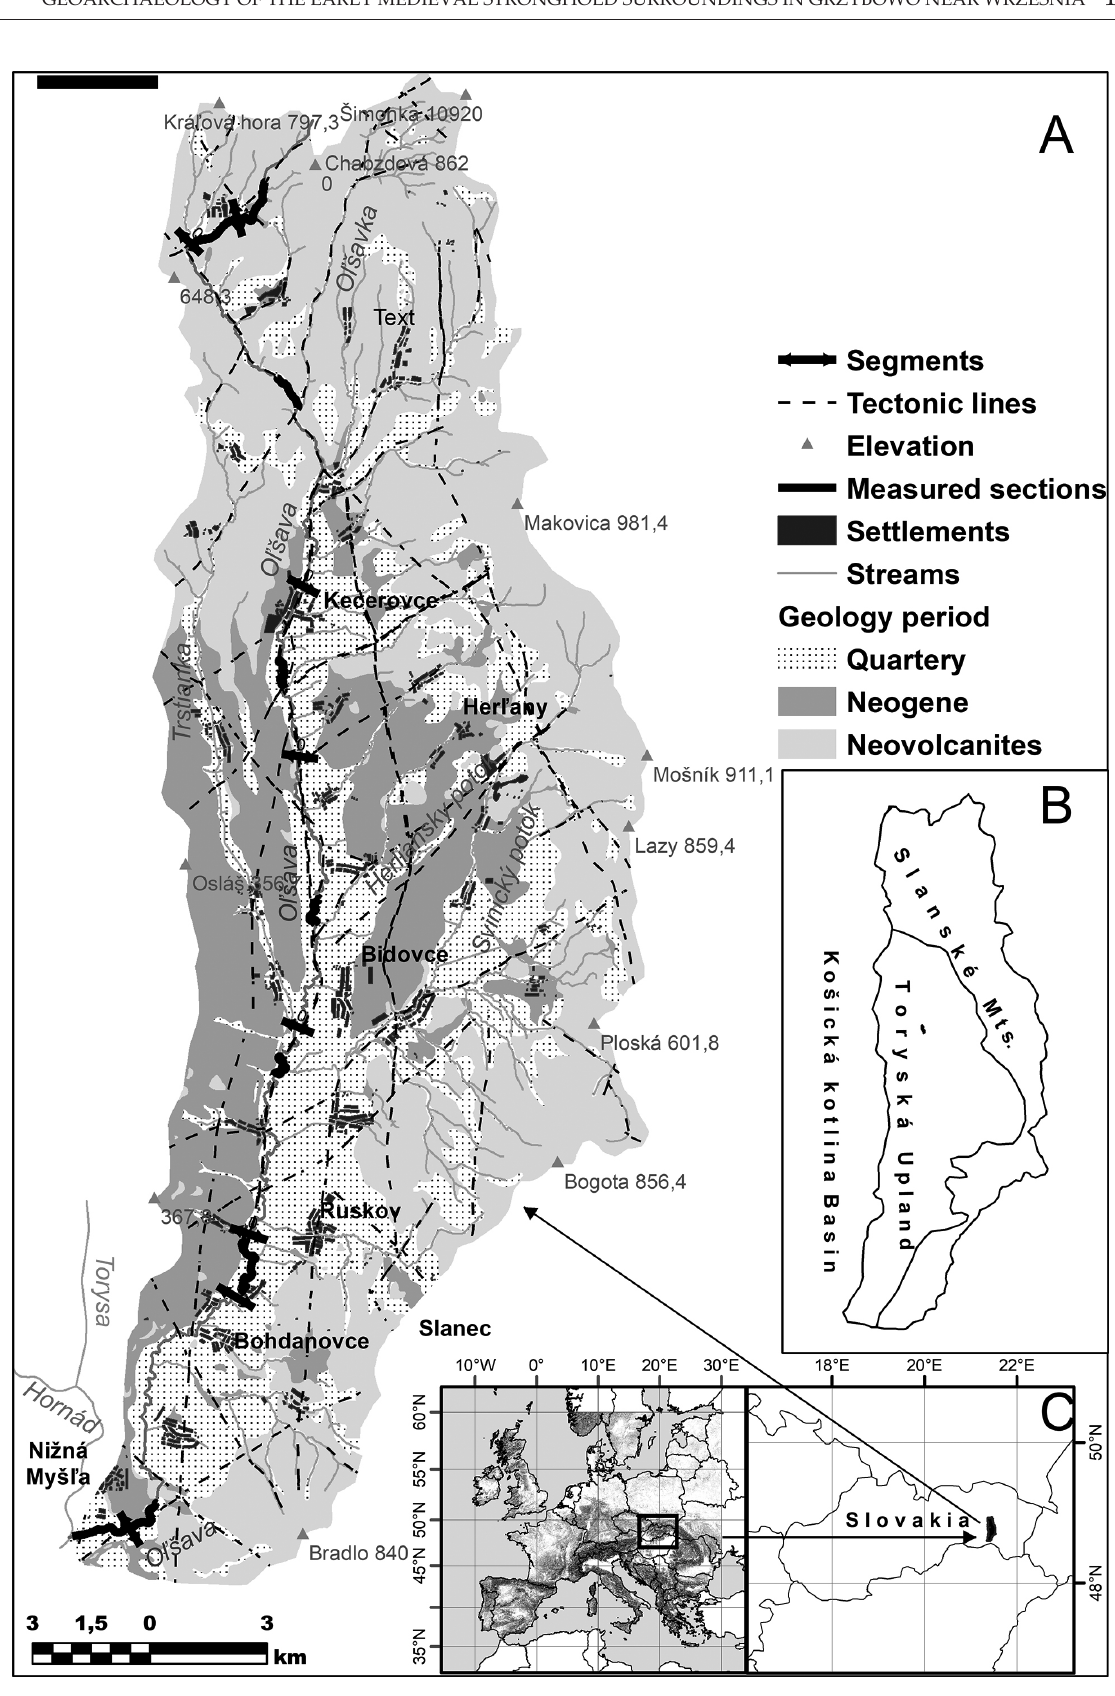
fig. 1. Geological and tectonic structure of the Oľšava river catchment (A), geomorphological units of the Oľšava catchment area (B), the location of the basin